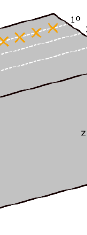
Figure 1. Block test